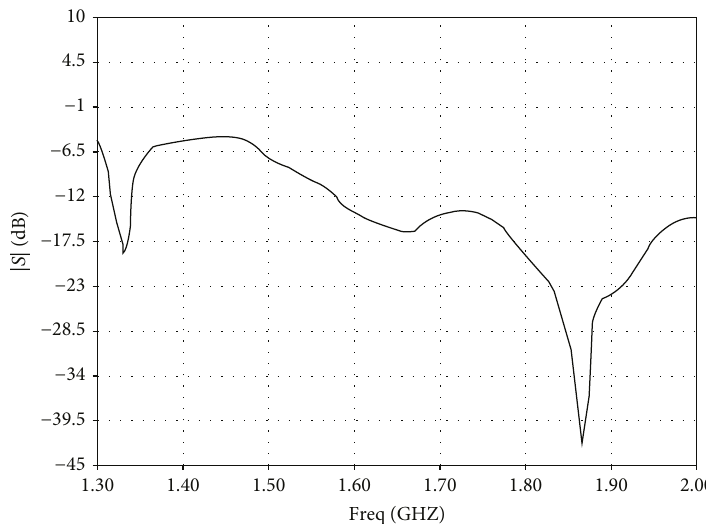
Figure 10: Measured S -parameters for a single unit.